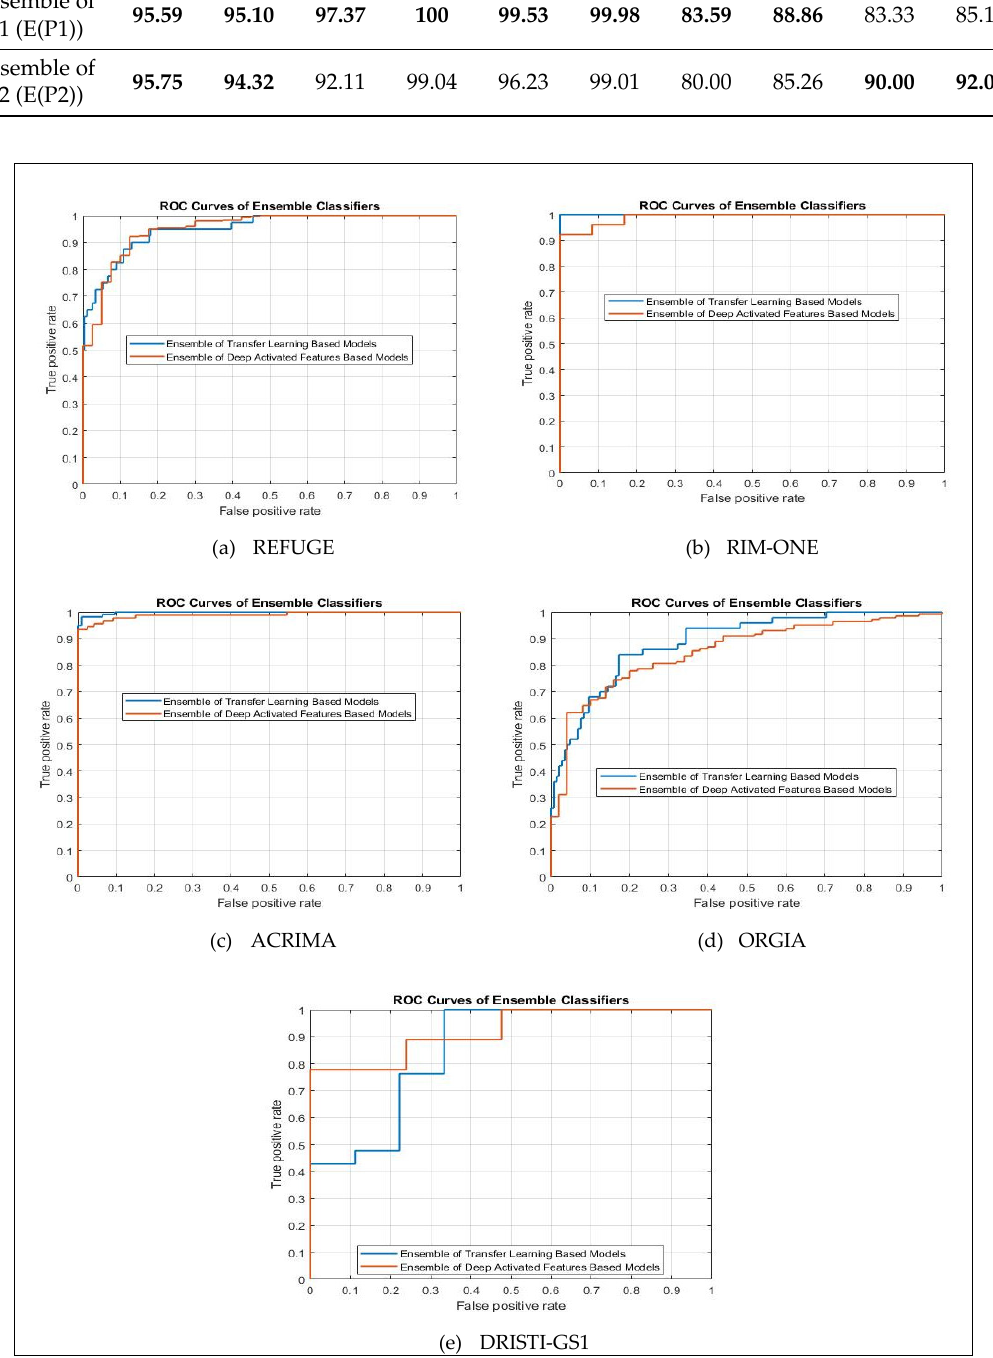
Figure 10. ROC curves of ensemble methods using five different datasets ( a ) REFUGE, ( b ) RIM-ONE, ( c ) ACRIMA, ( d ) ORIGA and ( e ) DRISTI-GS1.